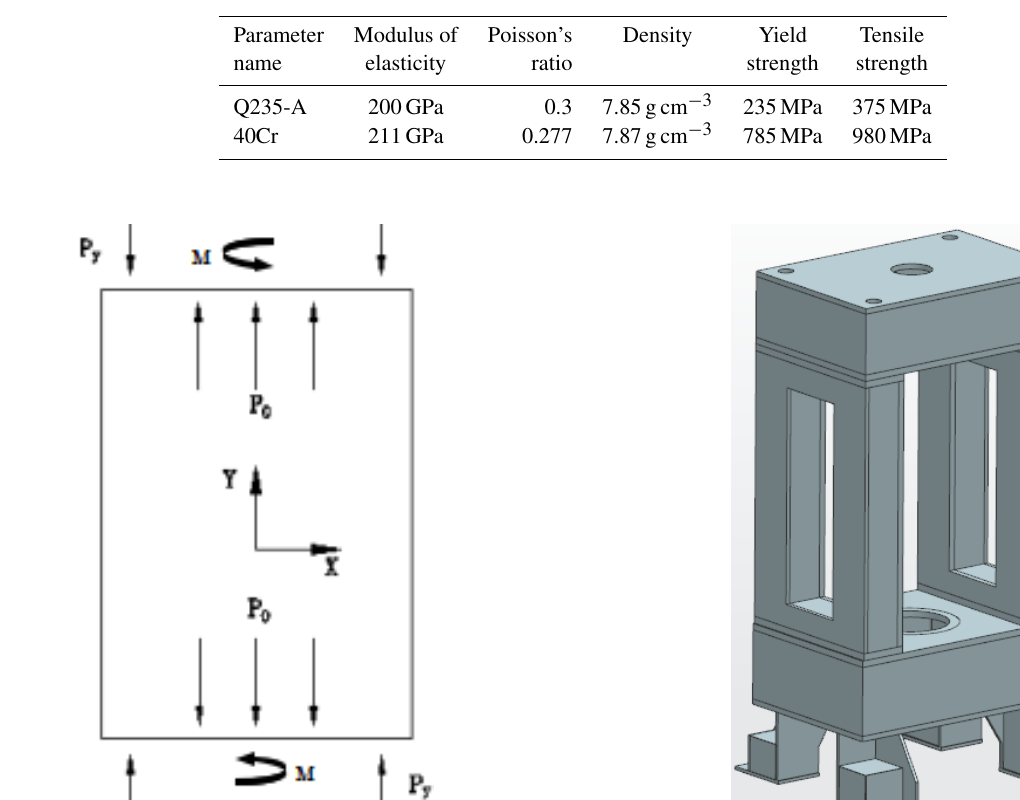
Table 1. Main material parameters.